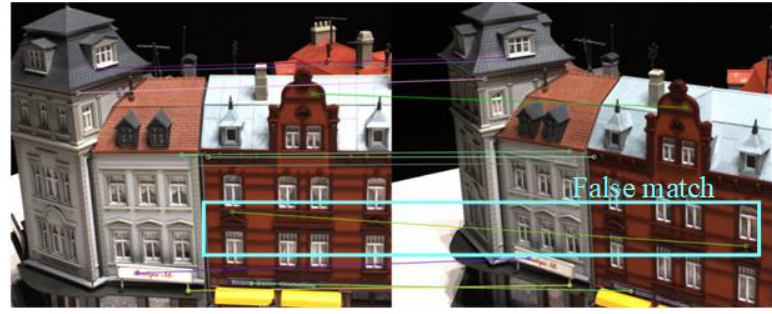
Figure 7. Incorrect feature point matching in images with repeated textures.